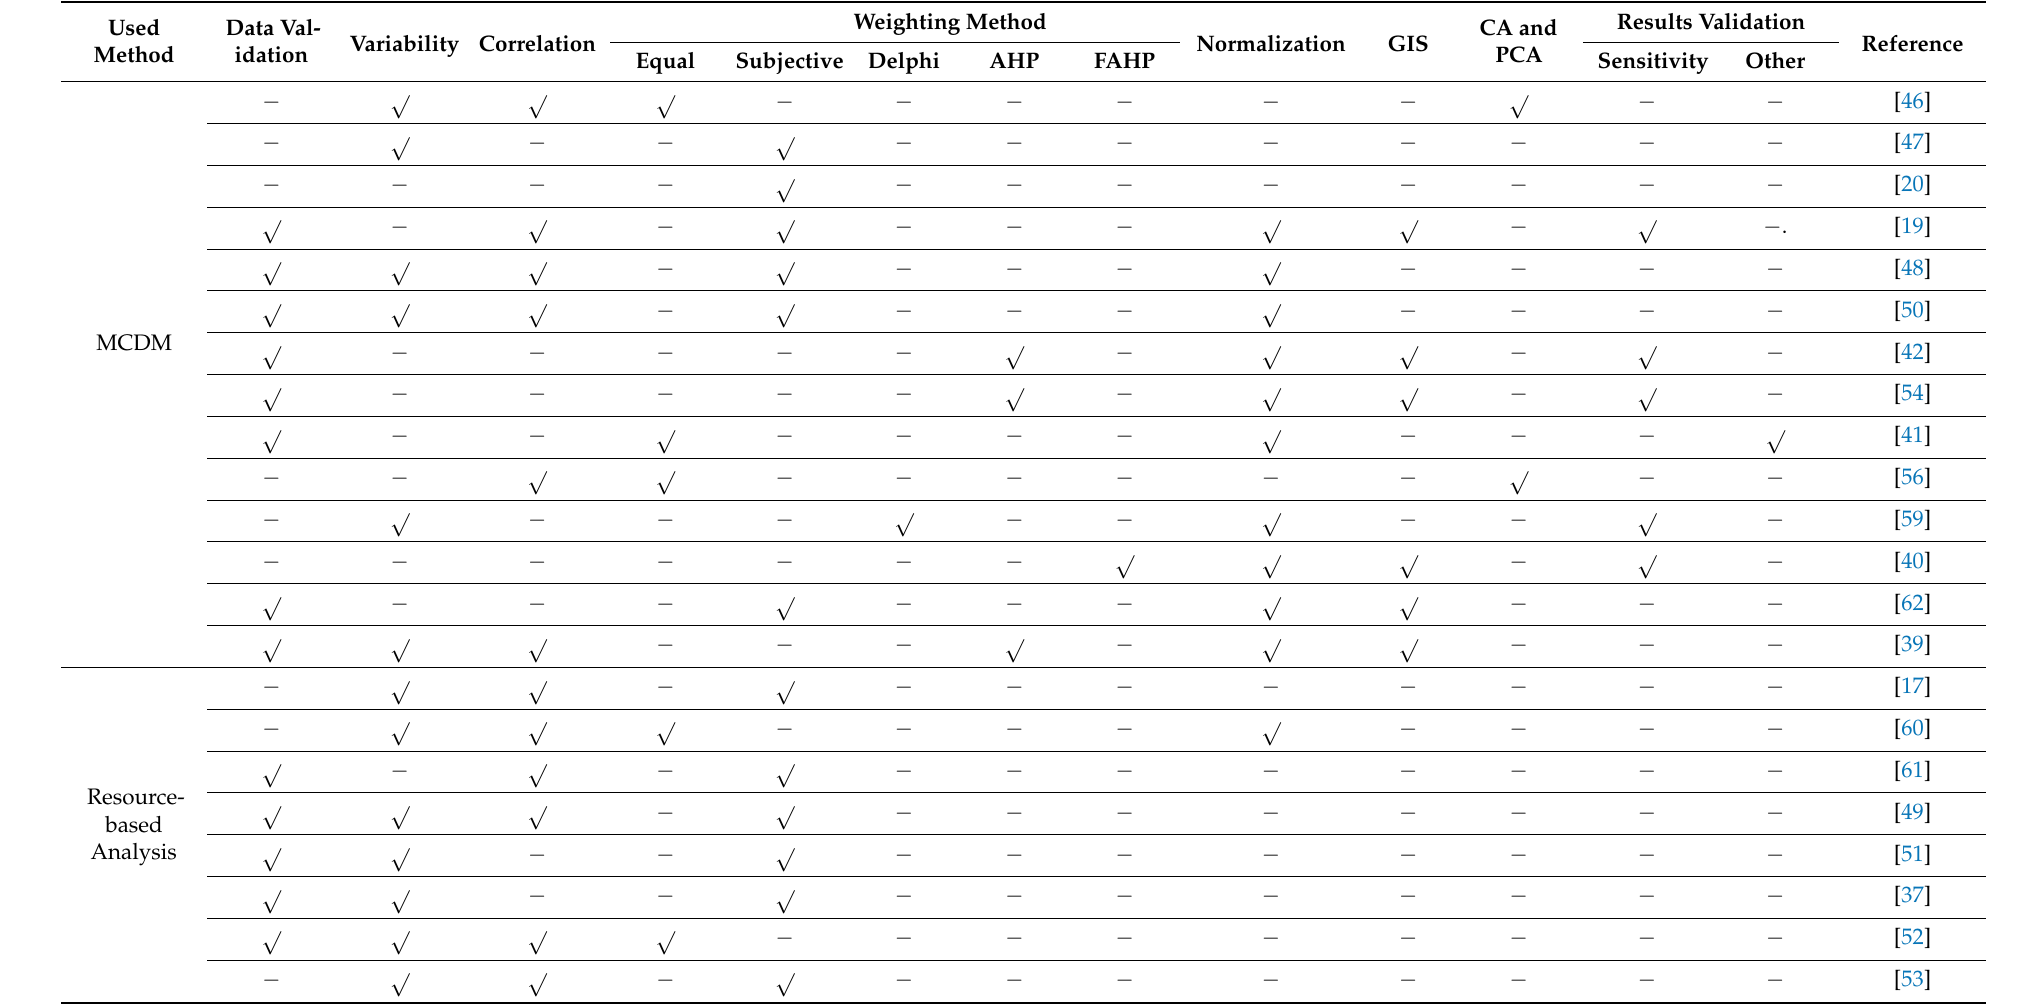
Table 3. COWWEF site selection analytical methods used in the